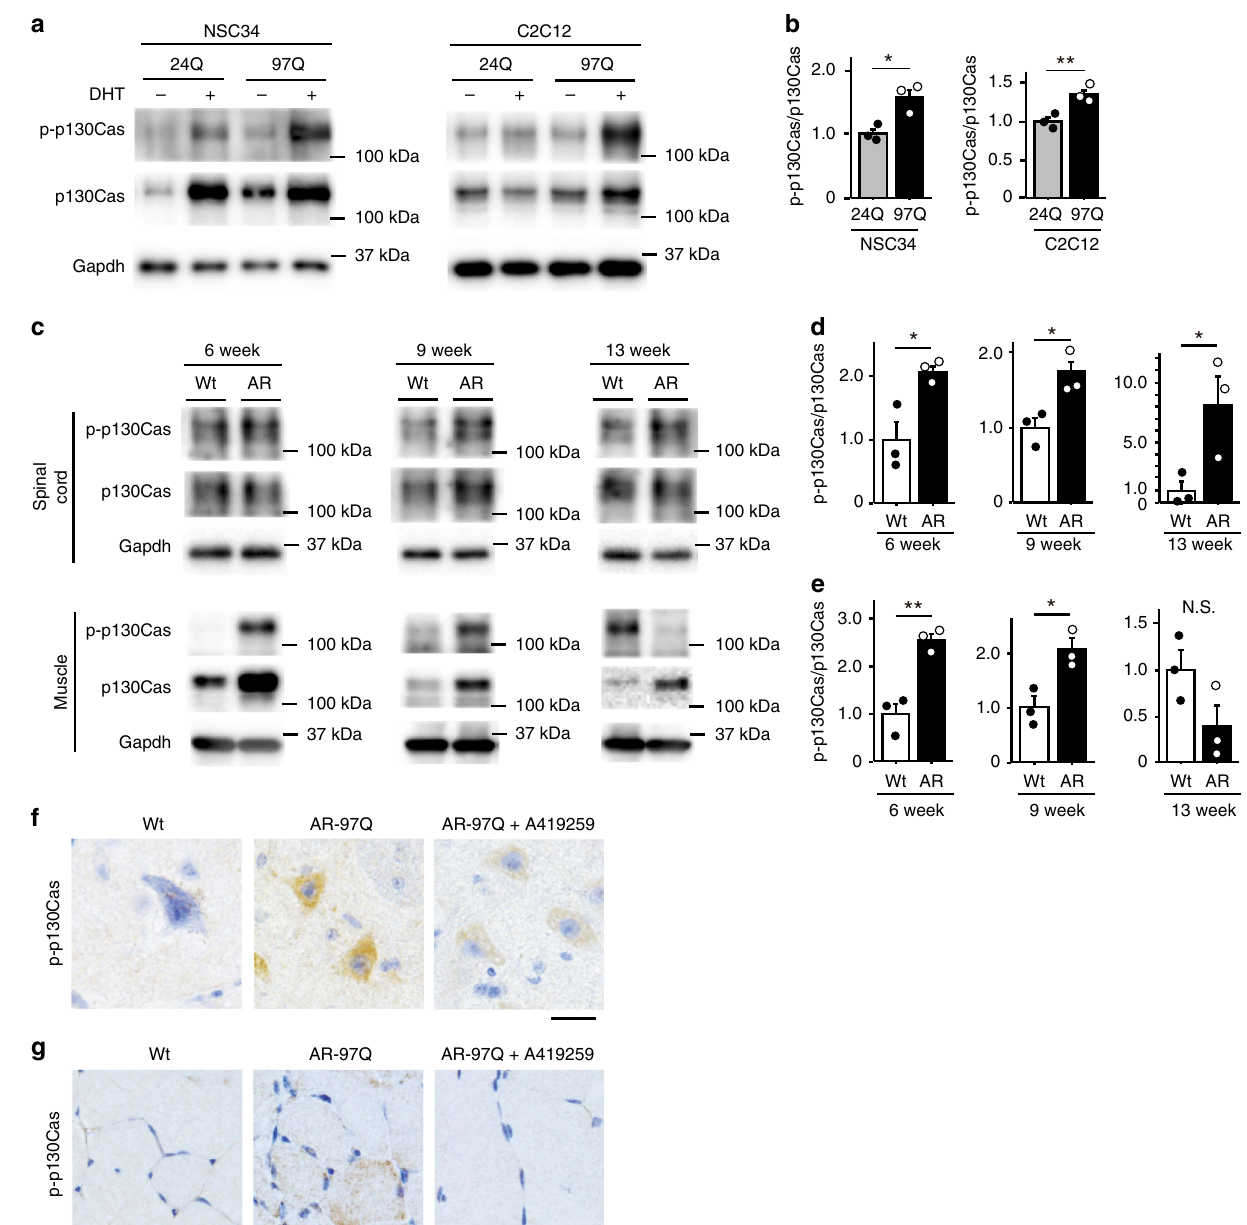
Fig. 7 p130Cas is activated in cellular and mouse models of SBMA. a , b Immunoblots showing the levels of the phosphorylated and total p130Cas proteins in NSC34 cells and C2C12 cells stably expressing AR-24Q or AR-97Q that were treated with or without DHT ( a ). Quantitative analyses were performed using densitometry ( n = 3) ( b ). c – e Immunoblots showing levels of the p-p130Cas and p130Cas proteins in the spinal cord and skeletal muscle of wild-type and AR-97Q mice at 6, 9 and 13 weeks of age ( c ). Quantitative analyses were performed using densitometry ( n = 3) ( d , e ). f , g Immunohistochemistry for p-p130Cas in spinal cord ( f ) and skeletal muscle ( g ) samples from 6-week-old mice. Error bars indicate the s.e.m. Statistical analyses were performed using the unpaired two-sided t -test ( b , d , e ). * p < 0.05 and ** p < 0.01. Wt, wild-type; AR, AR-97Q; N.S., not signi fi cant. Scale bars: 25 µ m ( f, g ). Source data